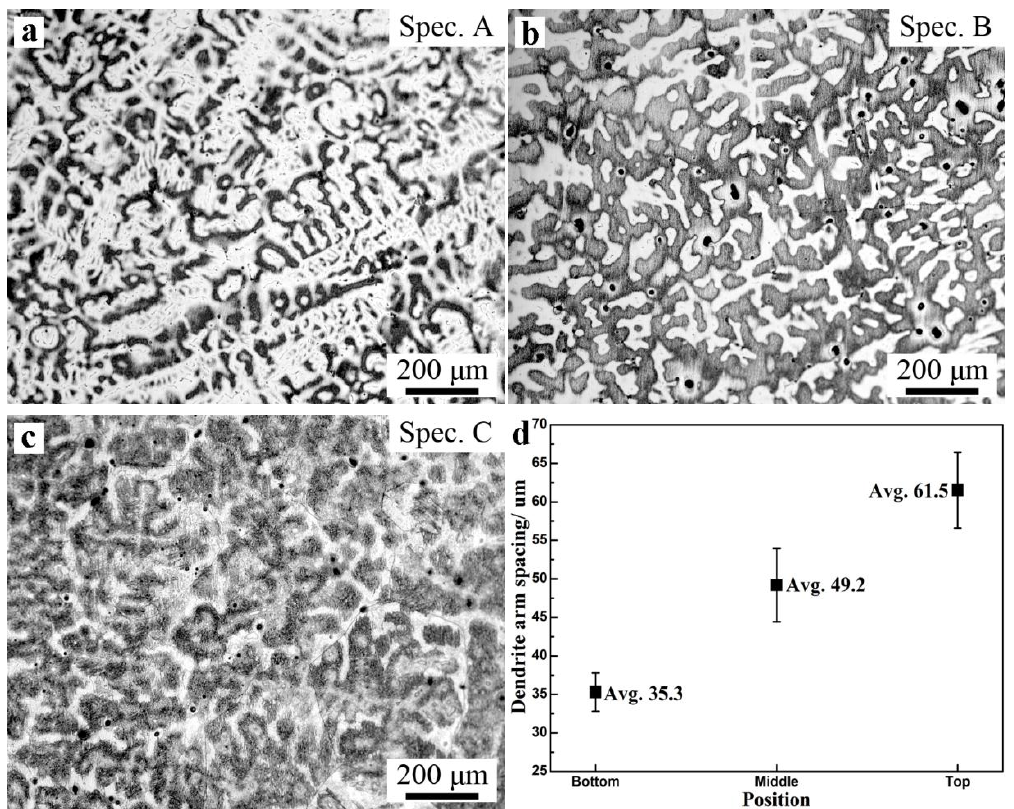
Figure 3. Optical micrographs of the ( a ) Spec. A, NiCrMoV, ( b ) Spec. B, transition zone (TZ), and ( c ) Spec. C, CrMoV in the ESR ingot; ( d ) secondary dendritic arm spacing at different positions (A, B, and C) of the ESR ingot.